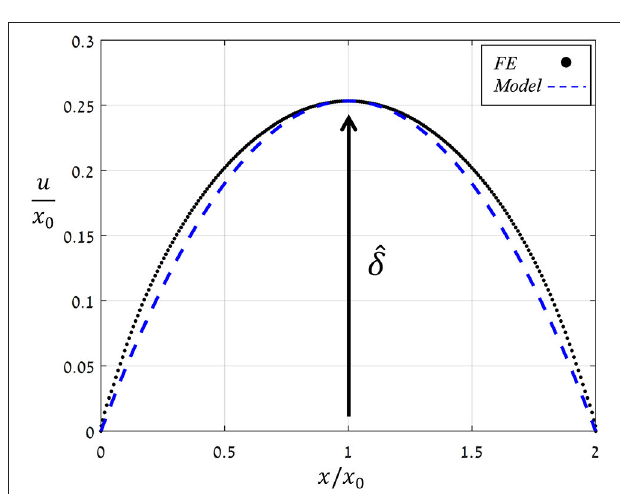
FIGURE 6 | Normalized opening displacement along the stoma ( u / x 0 ) vs. the normalized location ( x / x 0 ) as obtained by FE simulations for ˆ P ˆ E = 10 (black dots) and by simplified theoretical modeling of a parabolic opening displacement (blue dashed line). The normalized aperture ˆ δ indicated. The same trend was obtained for all ˆ E - and ˆ P -values analyzed.